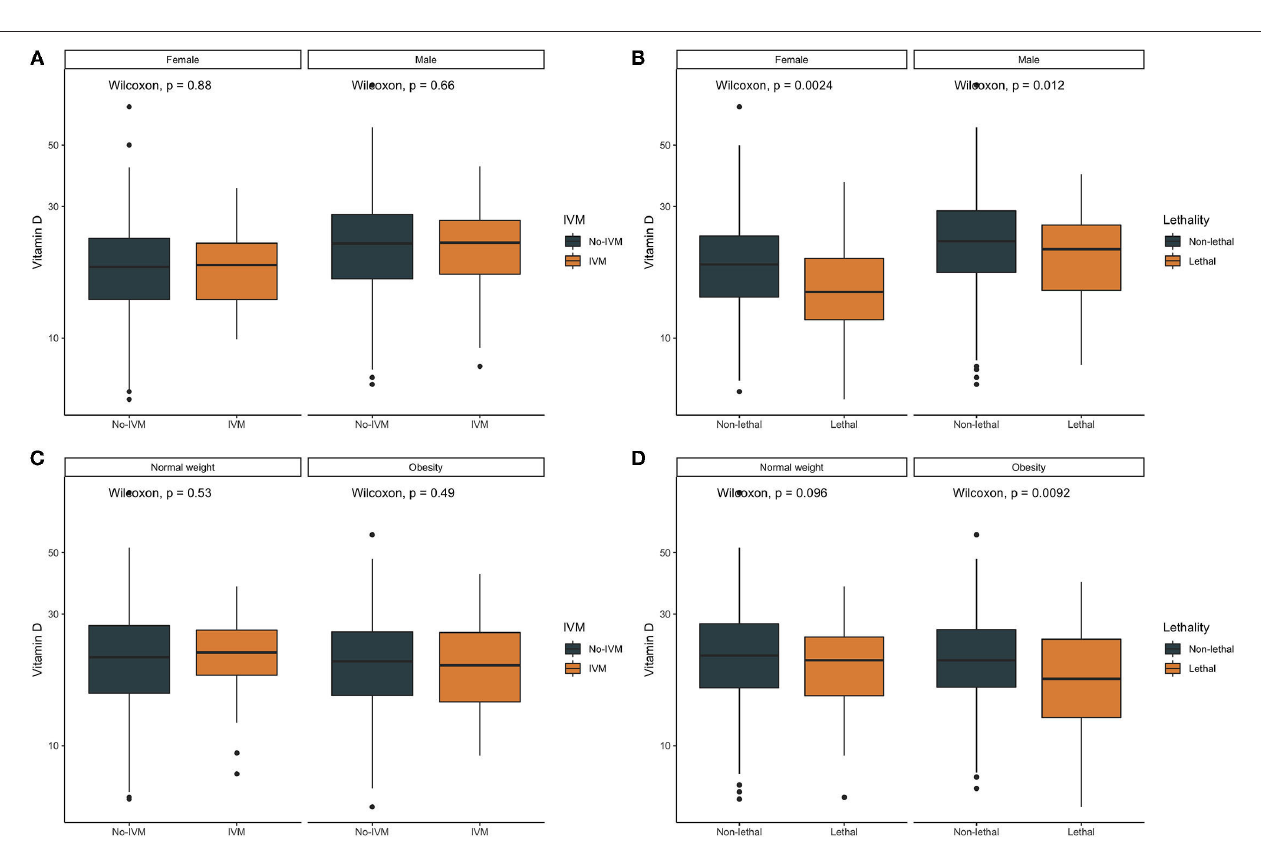
FIGURE 1 | Boxplots comparing Vitamin D levels according to the need for invasive mechanical ventilation (IVM) or lethal COVID-19 stratified by gender (A,B) and by body-mass index categories (C,D) .